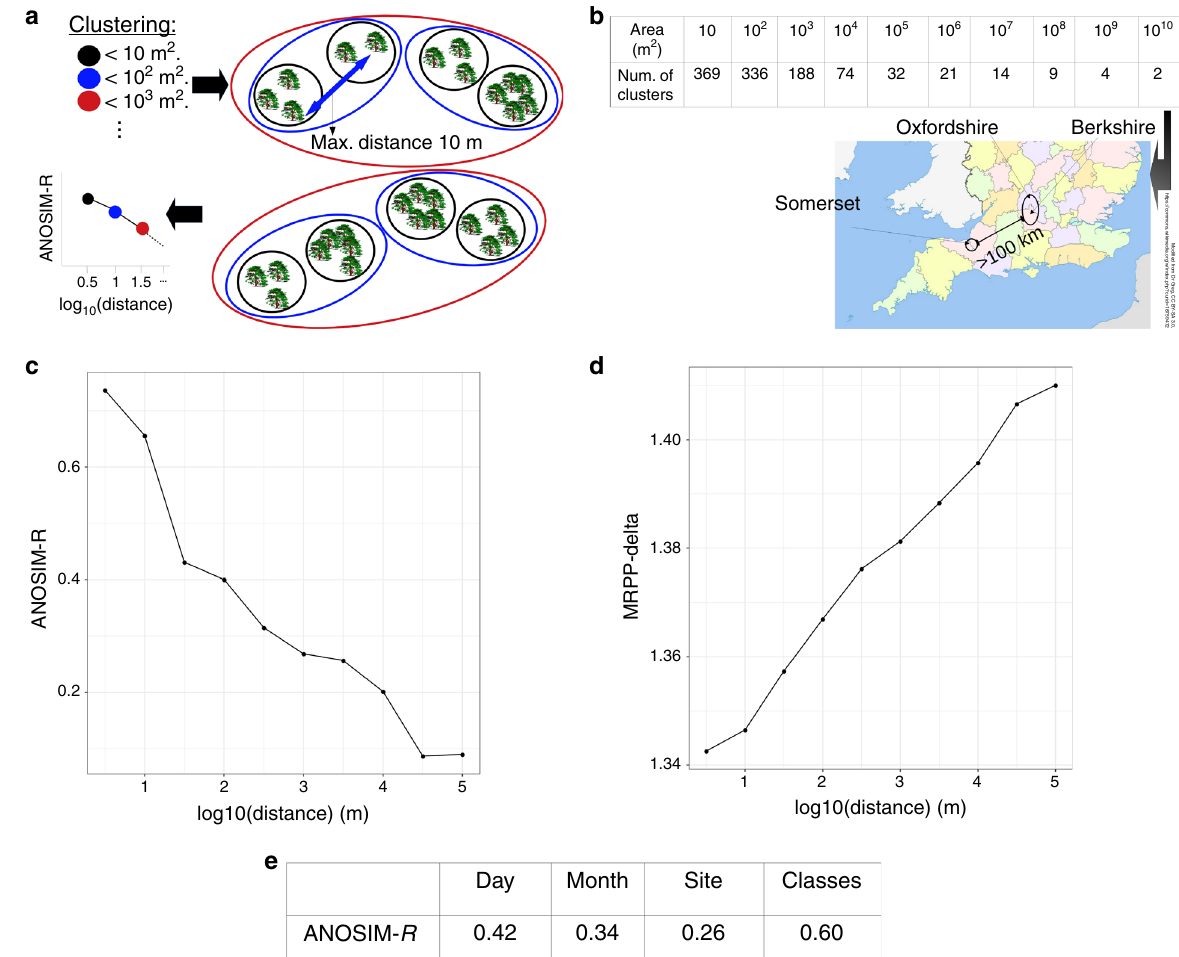
Fig. 1 Analysis of the decay of community similarity with distance. a Illustration of the procedure. Trees are clustered within areas A of increasing sizes, leading to one classi fi cation every order of magnitude (ellipses of different colours). We approximated these areas by stopping the clustering at spatial ffiffiffiffi p A distances thresholds equal to , e.g., the classi fi cation for areas of 100 m 2 (blue ellipses) is obtained by stopping at d = 10 m. For each classi fi cation, an ANOSIM and MRPP value was computed to test if the similarity of the communities within the clusters is larger than between clusters, and the statistics were plotted against the spatial threshold. b Number of clusters at each spatial threshold. The three counties from which the communities were sampled are shown in the map. The classi fi cation at the last threshold consists of two clusters separated by > 100 km. c , d Observed ANOSIM and MRPP statistics for each of the distance thresholds, re fl ecting a decay in the similarity of the communities (see Main Text for details). e ANOSIM values for communities clustered according to the day and month in which were sampled, the site from which they were collected (optimal classi fi cation of spatial distances), and the six community classes (optimal classi fi cation of β - diversity